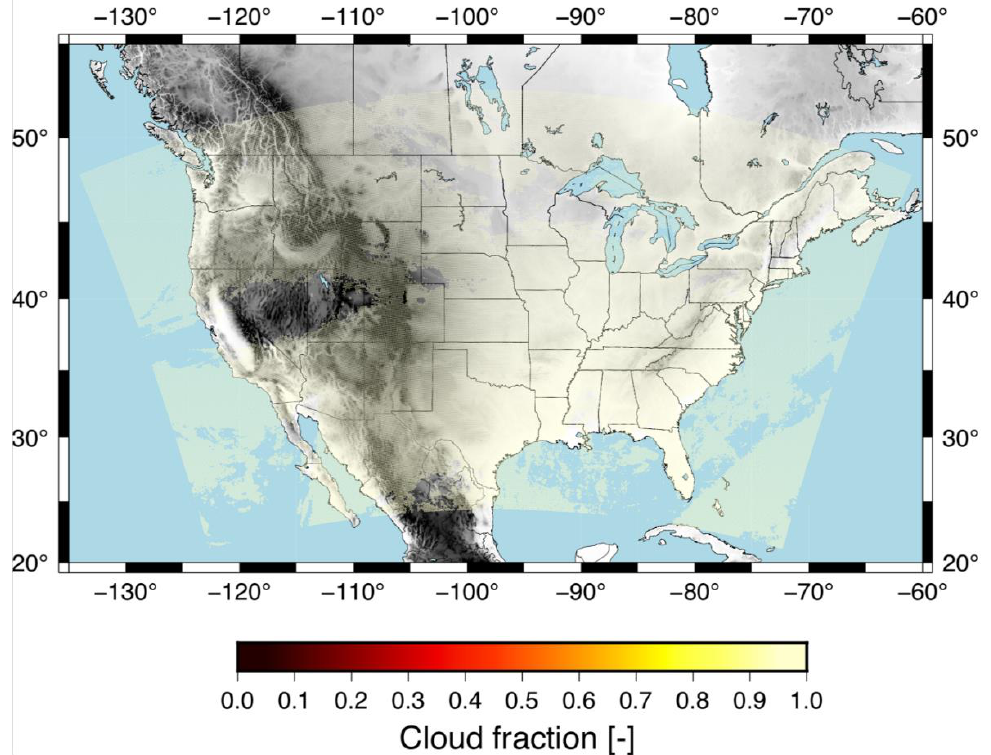
Figure 10. RF algorithm cloud mask product for 1 April 2018 at